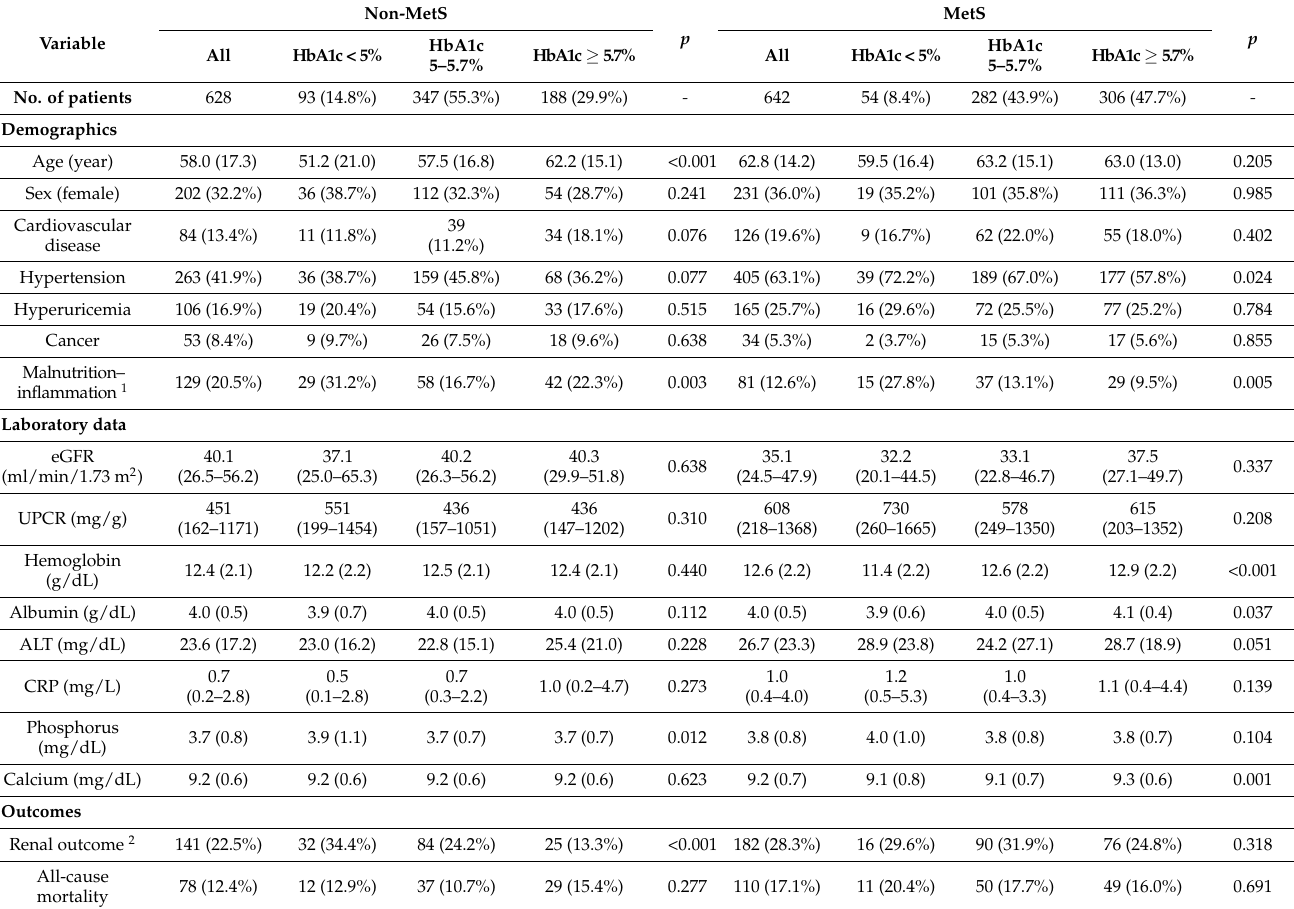
Table 1. Baseline characteristics of non-diabetic CKD stage 1–4 patients.